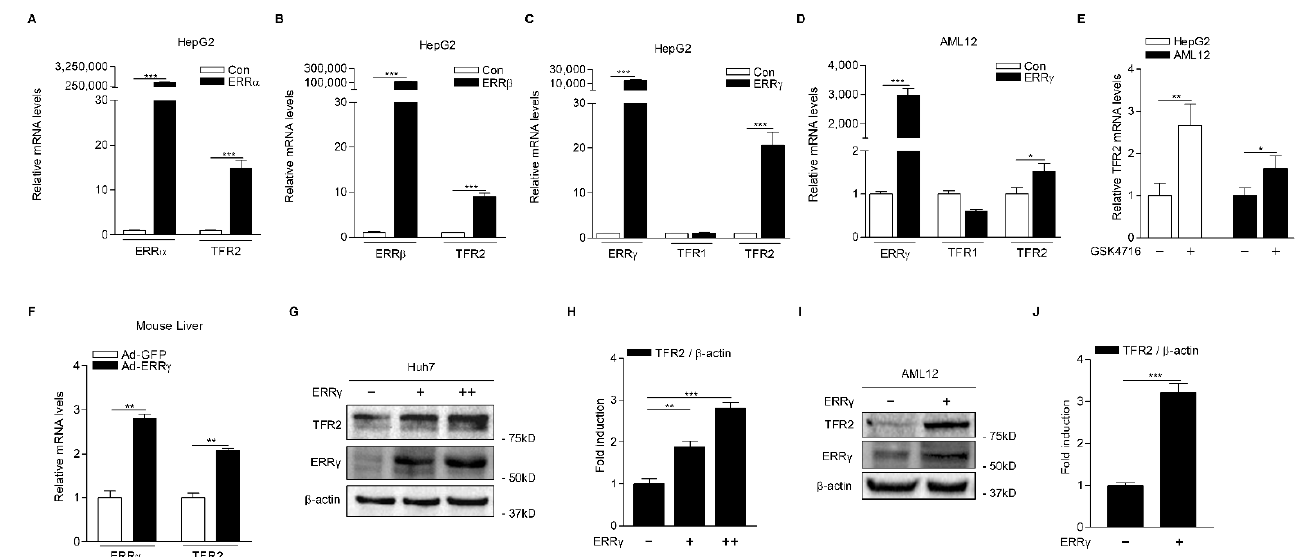
Figure 3. ERR γ increases TFR2 mRNA and protein levels. ( A – C ) Q-PCR analysis showing ERR γ , TFR1, and TFR2 mRNA levels. HepG2 cells were transfected with vectors expressing ERR α ( A ), ERR β ( B ), and ERR γ ( C ) for 48 h. ( D ) Q-PCR analysis showing ERR γ , TFR1, and TFR2 mRNA levels. AML12 cells were transfected with vector expressing ERR γ for 48 h. ( E ) Q-PCR analysis showing TFR2 mRNA levels. HepG2 cells and AML12 cells were treated with GSK4716 (10 μ M) for 12 h. ( F ) Q-PCR analysis showing ERR γ and TFR2 mRNA levels in the liver. Ad-GFP and Ad-ERR γ were injected via tail veins into male C57BL/6J mice ( n = 3 per group). Mice were then sacrificed at day 6. ( G , H ) Western blot analysis ( G ) and graphical representation ( H ) showing TFR2 protein levels. Huh7 cells were transfected with vector expressing ERR γ (+: 1 μ g, ++: 3 μ g) for 48 h. ( I , J ) Western blot analysis ( I ) and graphical representation ( J ) showing TFR2 protein levels. AML12 cells were transfected with a vector expressing ERR γ (+: 3 μ g) for 48 h. Experiments were performed in duplicate ( G – J ) or triplicate ( A – F ) and repeated at least twice. Error bars show ± SD. * p < 0.05, ** p < 0.01, *** p < 0.001 by two-tailed Student’s t -test.